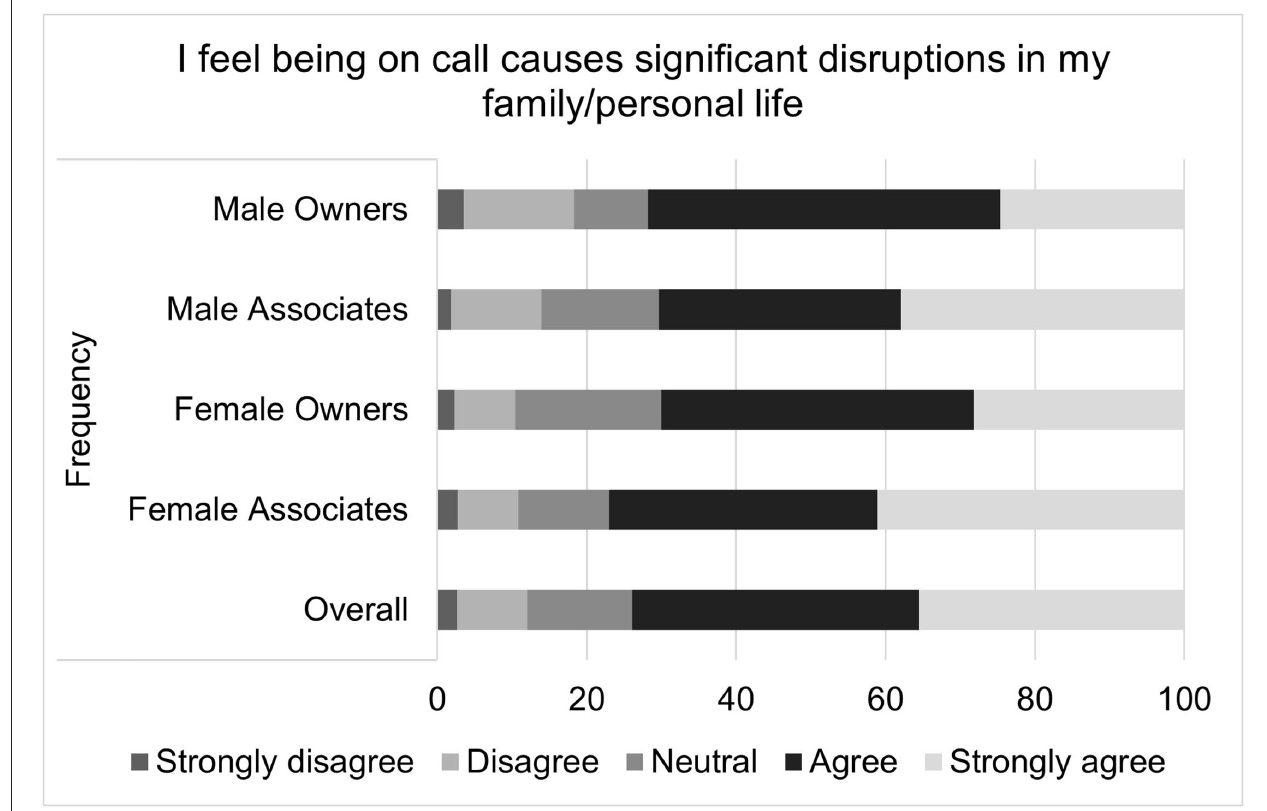
FIGURE 6 | Perceived negative effects of on-call duties on physical health, as reported by male and female practice owners and associate